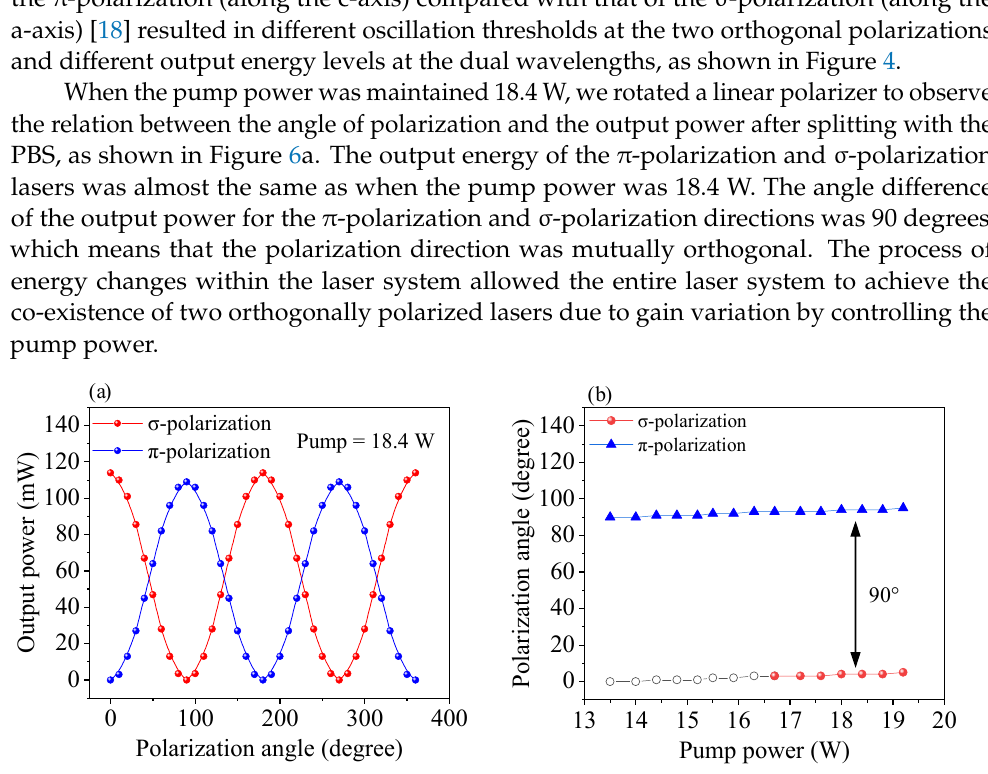
7 of 10 Figure 5. ( a ) Optical spectra of the orthogonally polarized dual-wavelength Ho:LLF laser and ( b ) emission wavelengths of the Ho:LLF laser with respect to pump power. In addition, the linearly polarized pump induced the parallel polarization of the self-